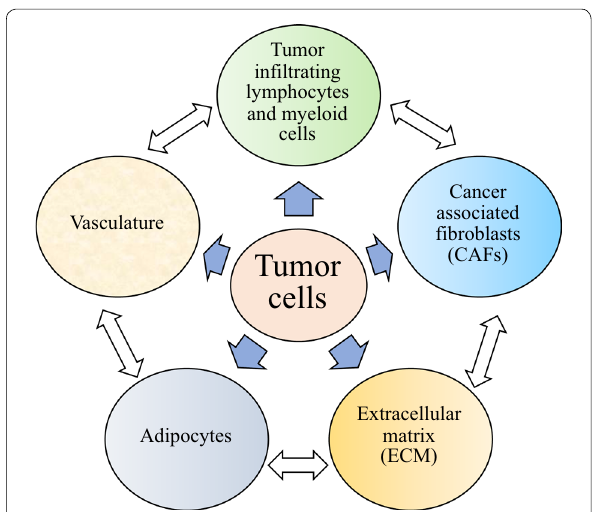
Fig. 1 Composition of the tumor microenvironment (TME). The tumor microenvironment is composed of tumor cells, cancer-associated fibroblasts (CAFs), the extracellular matrix (ECM), adipocytes, tumor vasculature and tumor-infiltrating lymphocytes and myeloid cells, all of which cross-talk intensively through cell surface molecules and/or soluble mediators to promote